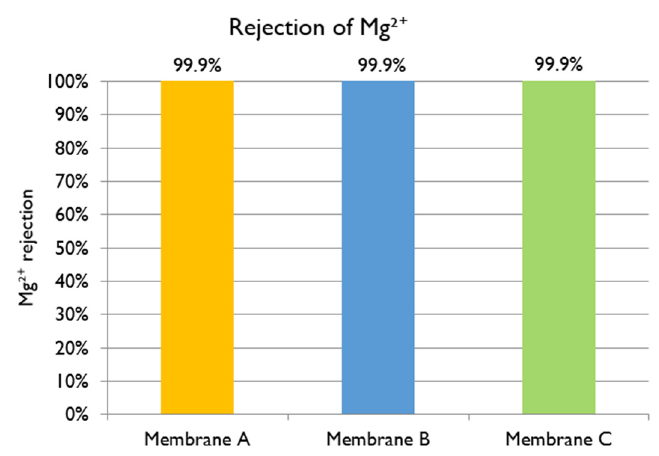
Figure 13. Rejection of Mg 2 ⁺ for membranes A, B, and C in the second experiment.